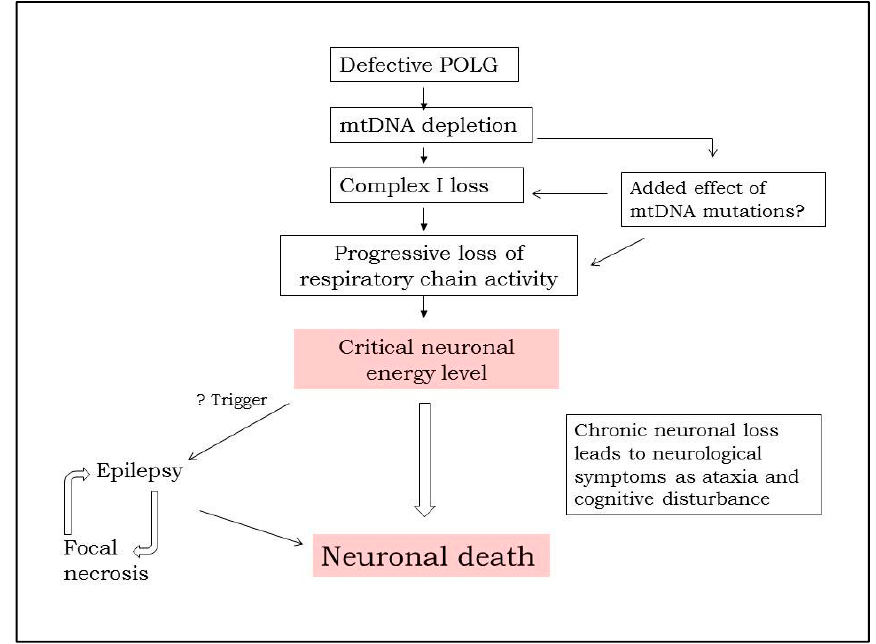
Figure 1. Schematic showing how POLG mutation can cause neuronal death and the role of epilepsy. Recessive mutations in the catalytic subunit of polymerase gamma (POLG) cause neuronal depletion of mtDNA. The level falls to ~40% and we believe that this is the threshold for neurones under which survival cannot be maintained. Depletion impairs the production of MRC components, and this